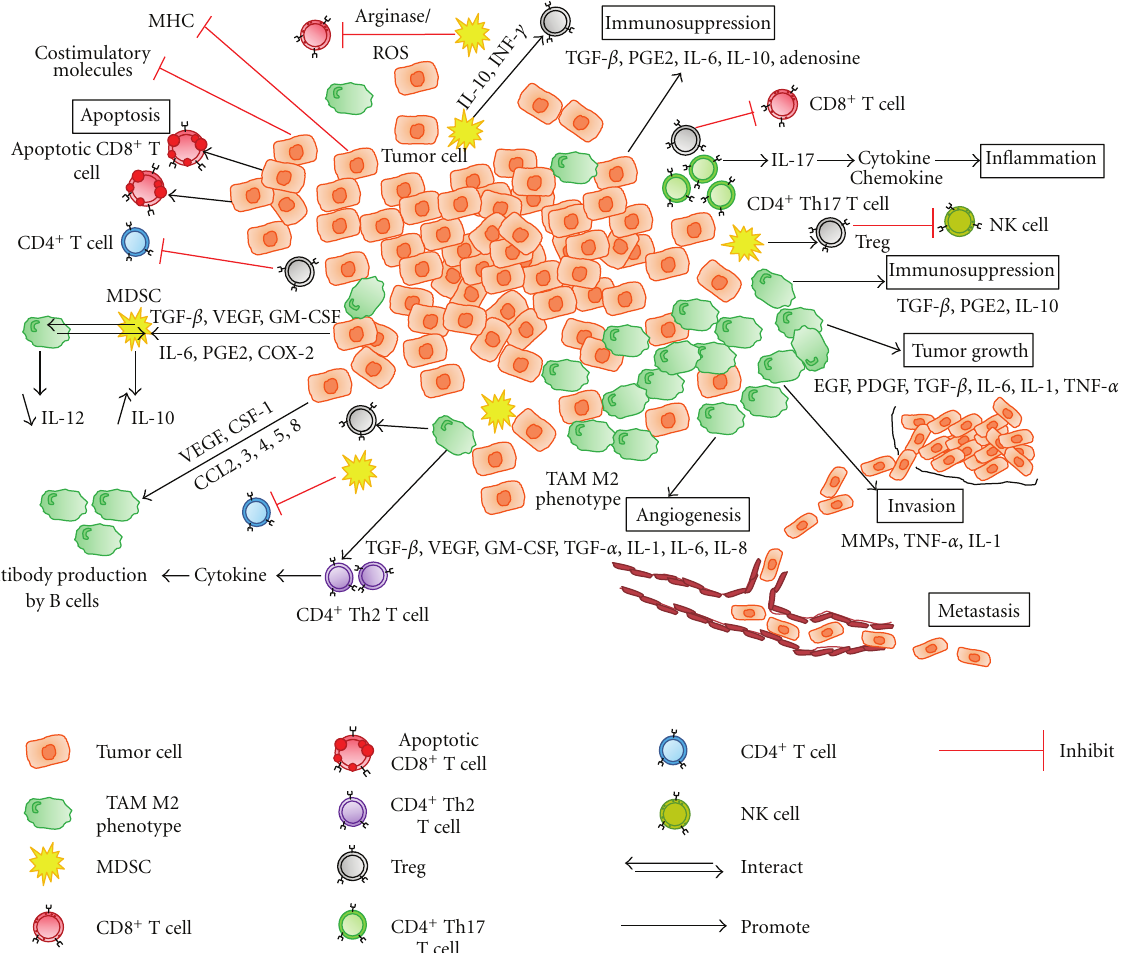
Figure 1: Immunosuppressive mechanisms in the tumor microenvironment: several mechanisms are developed by cancerous cells to escape to the immune system such as a loss or a reduction of the expression of MHC class 1 molecules and costimulatory molecules, the expression of FasL to induce apoptosis of tumor-infiltrating lymphocytes and the production of immunosuppressive molecules such as TGF- β , PGE2, IL-6, IL-10, and adenosine. Among the subpopulations of na¨ıve CD4 + T cells, CD4 + Th17 T cells promote inflammation by secreting IL-17 whereas CD4 + Th2 T cells promote antibody production by B cells. Tregs promote tumor progression by inhibiting the functions of CD4 + and CD8 + T cells and NK cells. TAMs M2 phenotype induce the expression of CD4 + Th2 T cell and Tregs. Moreover, M2 phenotype promote growth tumor (EGF, PDGF, TGF- β , IL-6, IL-1, and TNF- α ), angiogenesis (TGF- β , VEGF, GM-CSF, TGF- α , IL-1, IL-6, and IL-8), invasion (MMPs, TNF- α , IL-1), immunosuppression (TGF- β , PGE2, and IL-10) and metastasis. MDSCs induce Treg, secrete IL-10, and inhibit CD4 + and CD8 + T